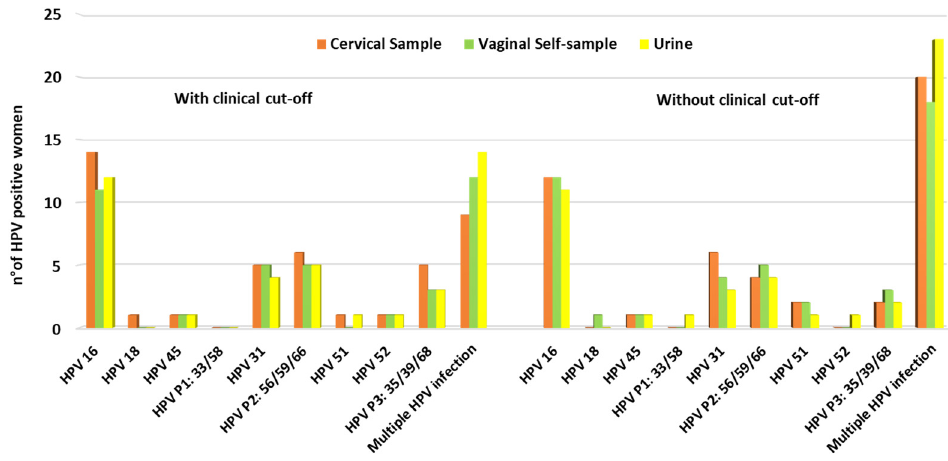
Figure 2. HPV genotype distribution analysed considering and not considering clinical cut-off.